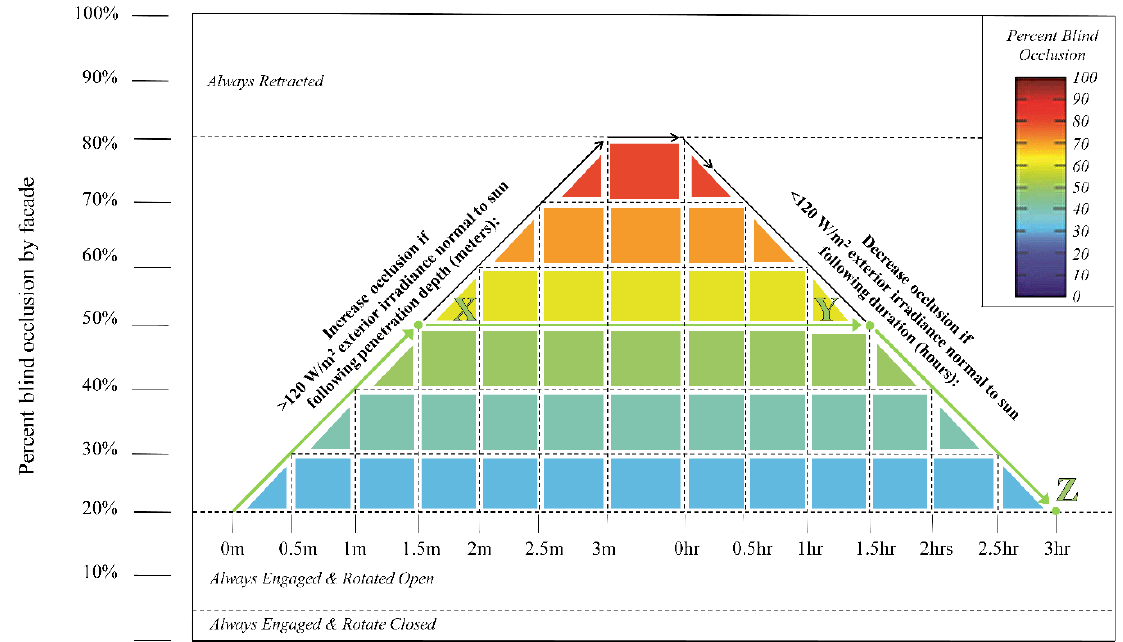
Figure 3. Operation algorithm for Blindswitch A—following Van Den Wymelenberg [5].